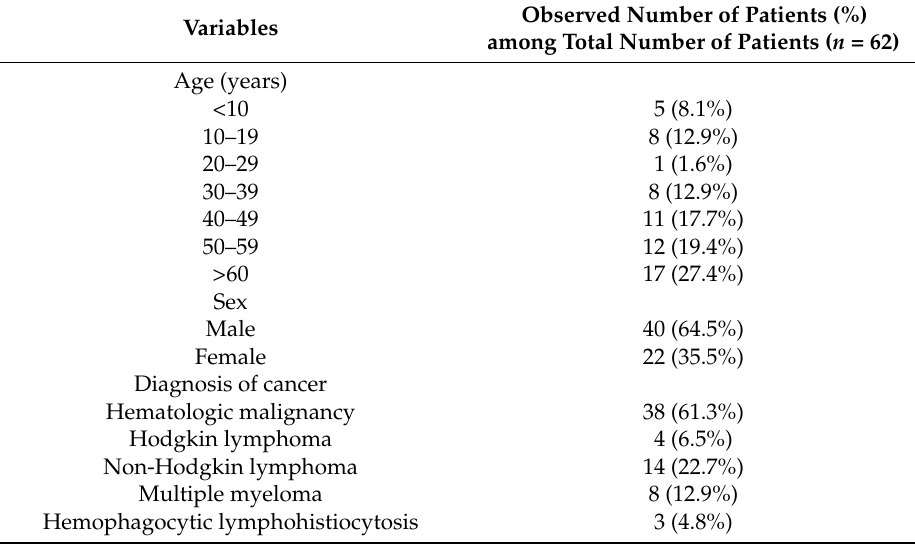
Table 1. Age, sex, and diagnosis of cancer patients with systemic capillary leak